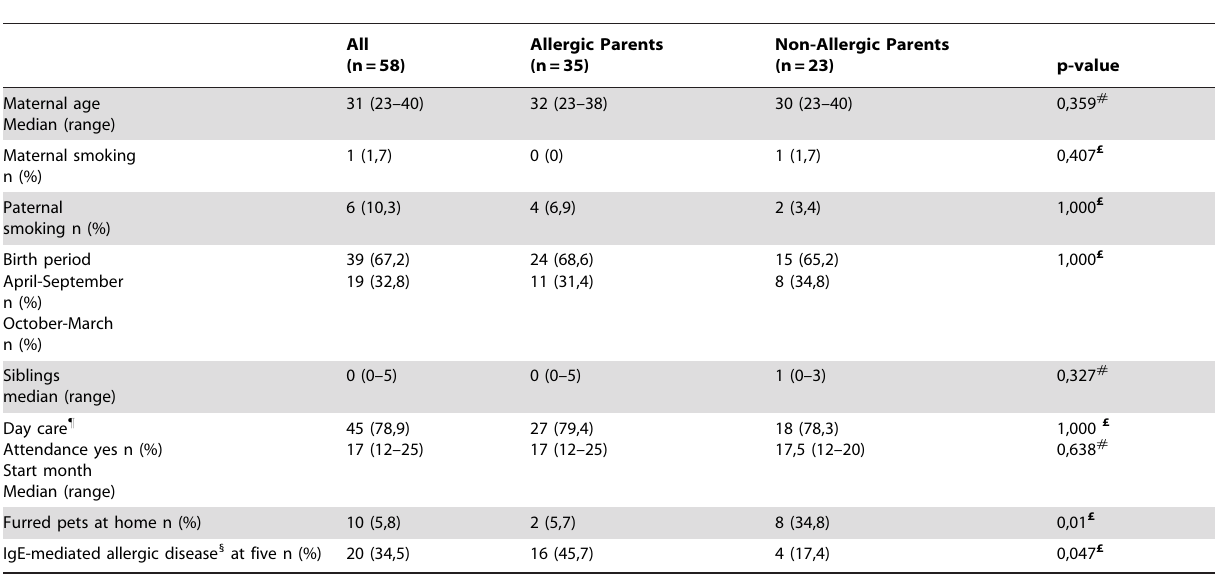
Table 1. Demographic data of the study